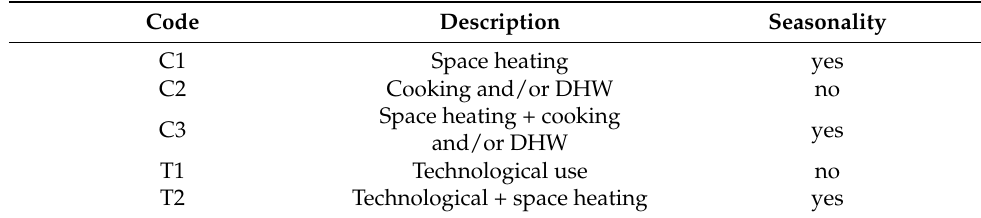
Table 2. Gas usage categories [32].